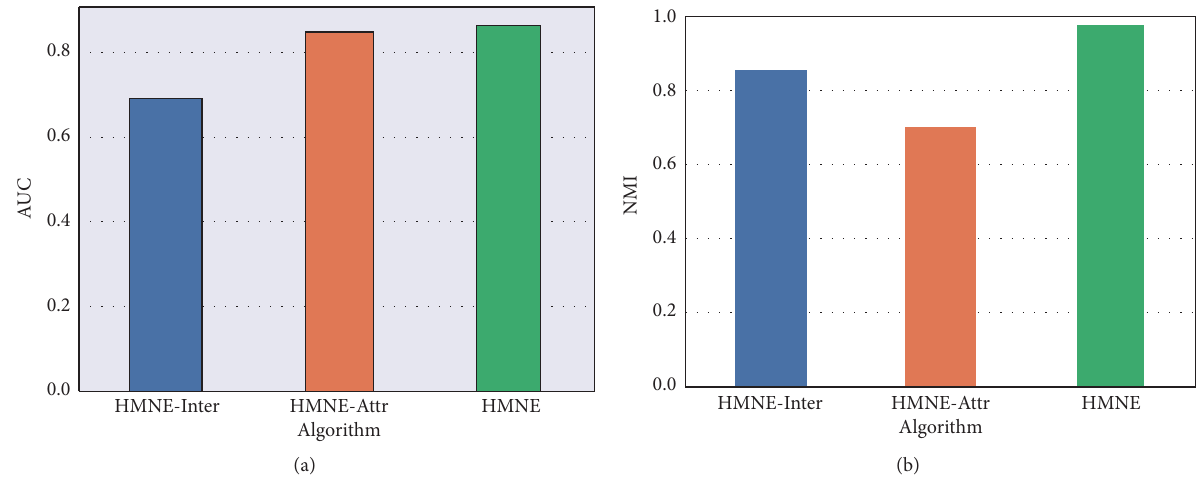
Figure 5: The effectiveness of different dependence properties in cross-domain link prediction and shared community detection tasks: (a) the effectiveness comparison in cross-domain link prediction; (b) the effectiveness comparison in the shared community detection